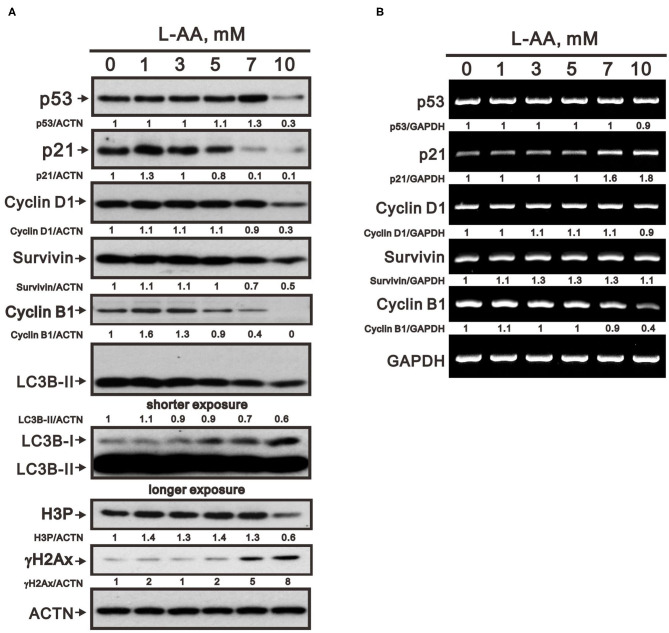
Effects of L-AA on expression of cell cycle-related proteins in HeLa cells. (A,B) HeLa cells (2 × 105 cells/well) were incubated for 40 h with the indicated concentrations of L-AA and then lysed. The cell lysates were subjected to Western blot analysis using antibodies against p53, p21, cyclin D1, Survivin, cyclin B1, LC3B, H3P, and γH2A.x (A); or to RT-PCR analysis for p53, p21, cyclin D1, Survivin, and cyclin B1
(B). ACTN was the protein loading control; GAPDH mRNA was the mRNA loading control. The results (A,B) are representative of three independent experiments. Protein and PCR bands were quantified through pixel density scanning and evaluated using ImageJ, version 1.44a (http://imagej.nih.gov/ij/). The fold was normalized to the internal control protein (ACTN) or gene (GAPDH).